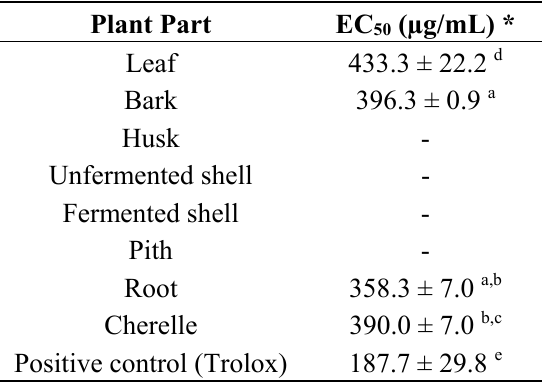
Table 1. Antioxidant activity of cocoa plant part